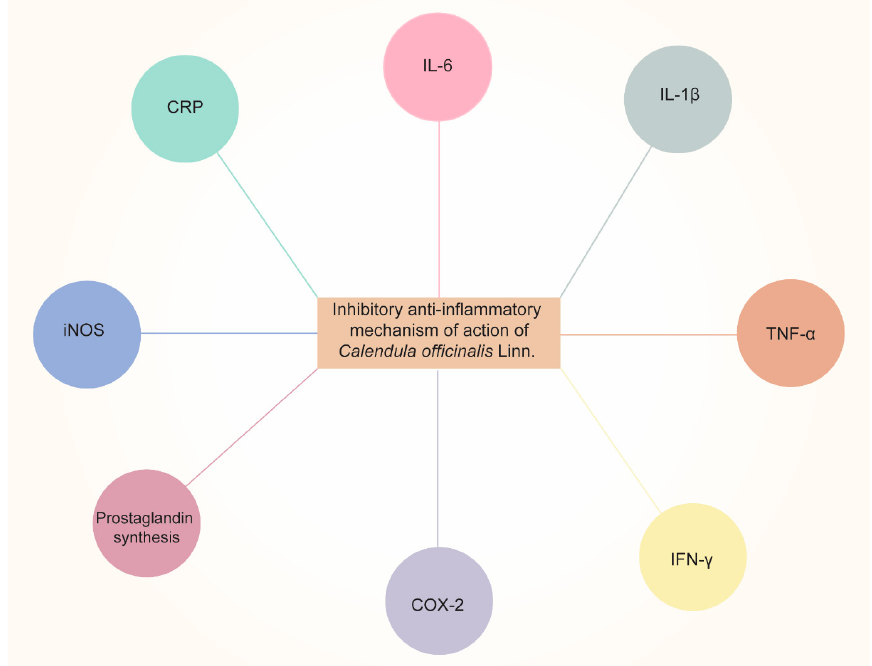
Figure 3. Anti-in fl ammatory e ff ects of Calendula o ffi cinalis Linn by inhibiting pro-in fl ammatory cytokines (IL-6, IL-1 β , TNF- α , and IFN- γ , etc.), COX-2, prostaglandin synthesis, iNOS (inducible nitric oxide synthase), and CRP (C-Reactive